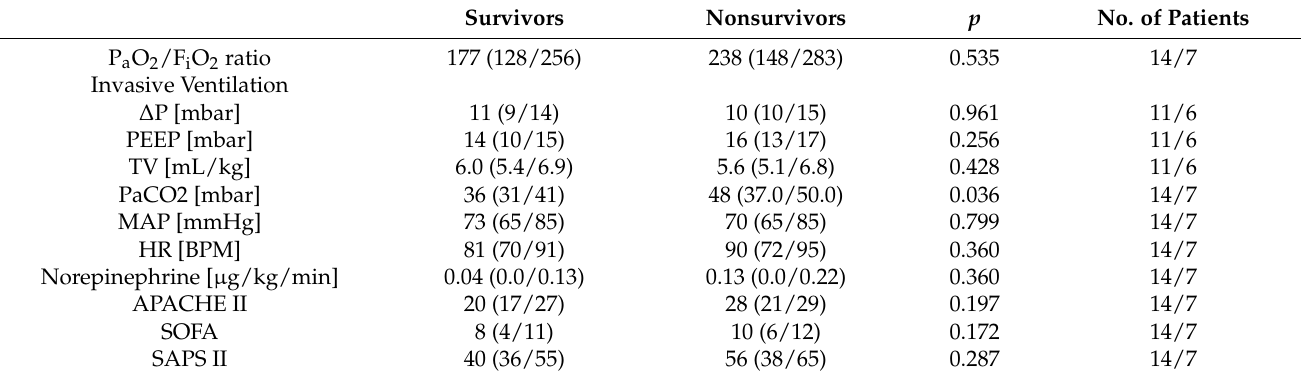
Table 5. TTE evaluated parameters for right ventricular function at EE and LE. EE